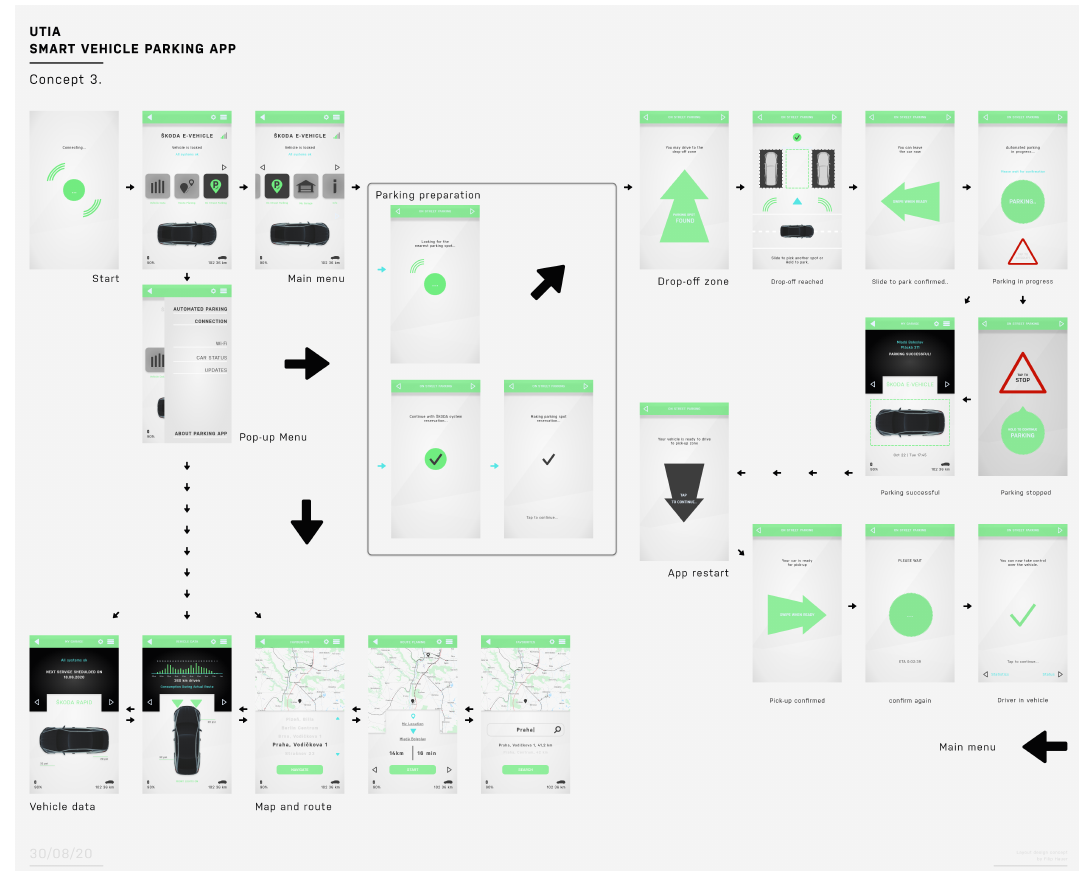
Figure 7. Smartphone human–machine